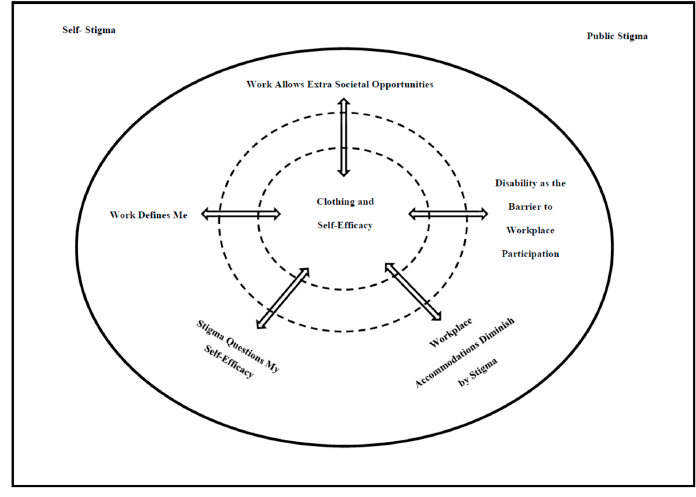
Figure 1. Goals of Workplace Participation for PLWD and Their